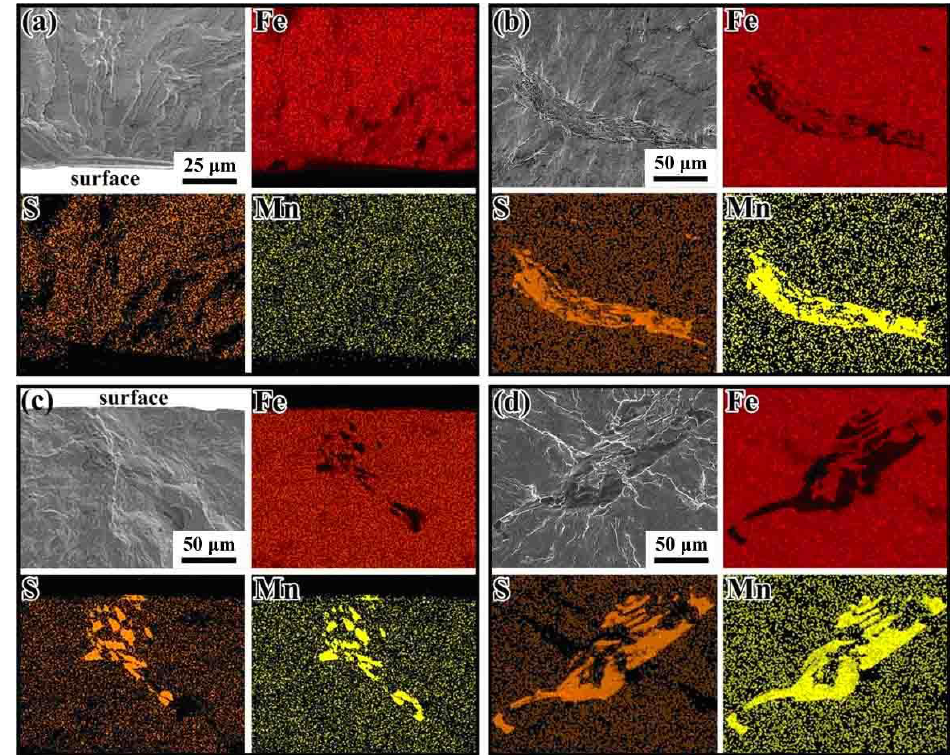
Figure 10. SEM images and EDX maps at the crack initiations on the fracture surface of failed